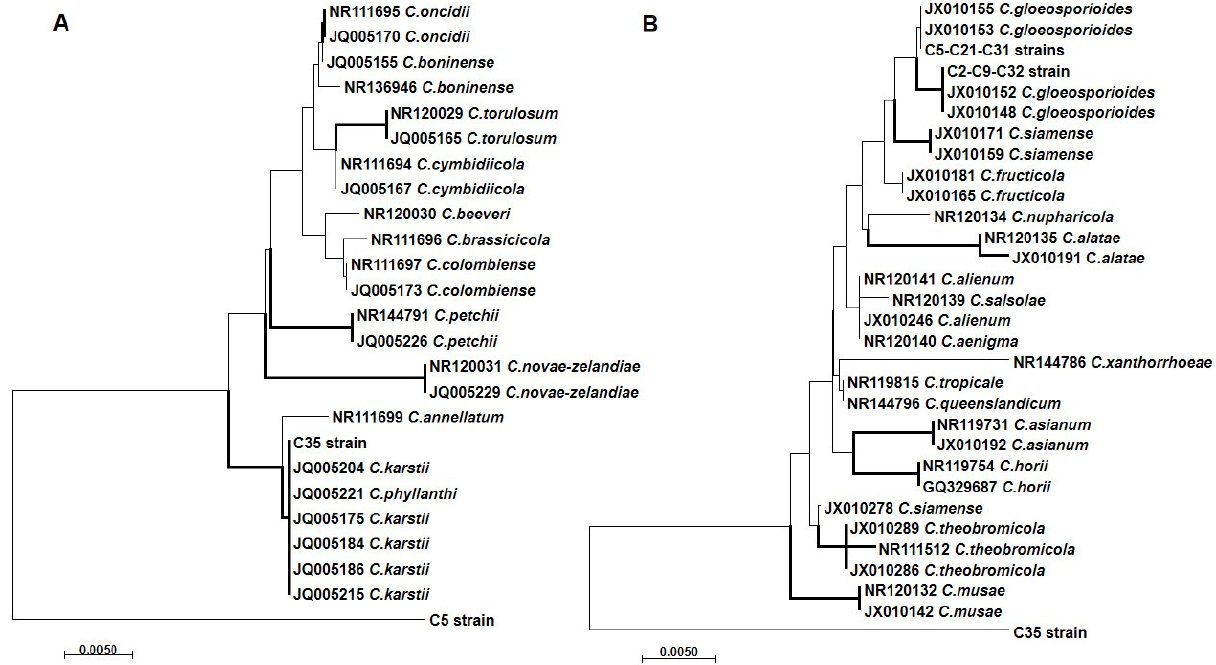
Figure 6. Maximum likelihood trees of Boninense (A) and Gloeosporioides (B) species complexes, based on the ITS1-5.8S-ITS2 region. Topologies resulting from maximum likelihood and Bayesian inference were congruent and the most likely trees are showed. Thickened branches are supported by likelihood bootstrap values of >70% and by Bayesian posterior probabilities of >95%. Taxa are labelled by their GenBank code (NR codes identify the type vouchers) or isolate code. Sequences from GenBank were selected based on results after Dumm et al. (2012) and Weir et al. (2012). Sequences of isolates C5 and C35 were differentially used as outgroups. The tree was edited using FigTree v 1.4.3.